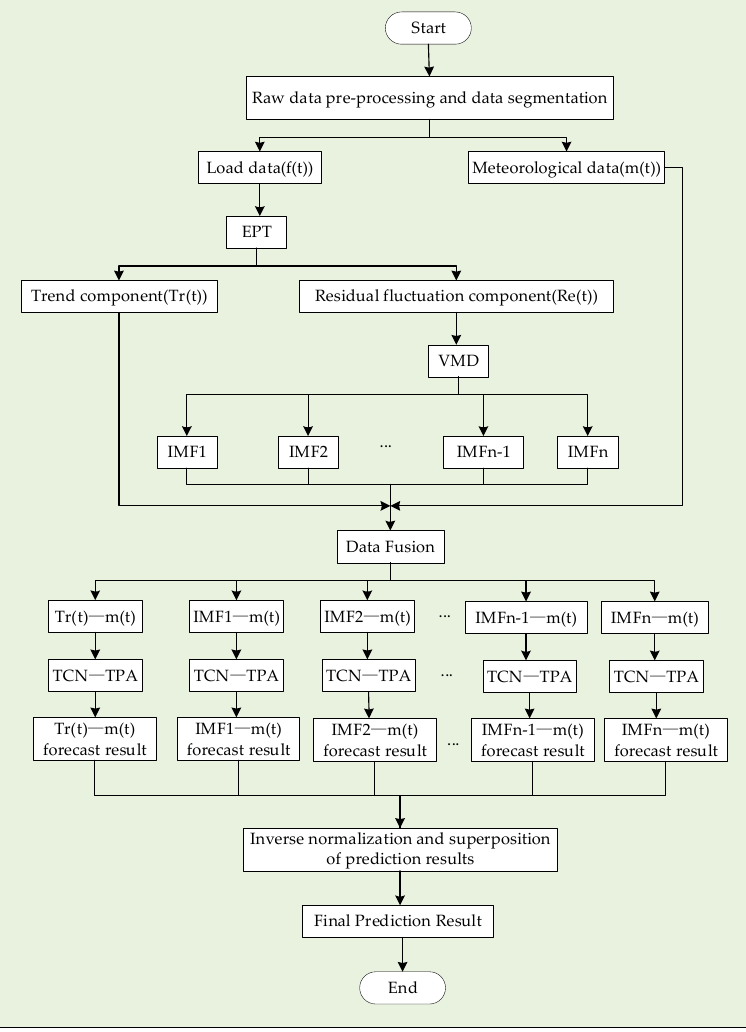
Figure 16. A flowchart of EPT-VMD-TCN-TPA model.